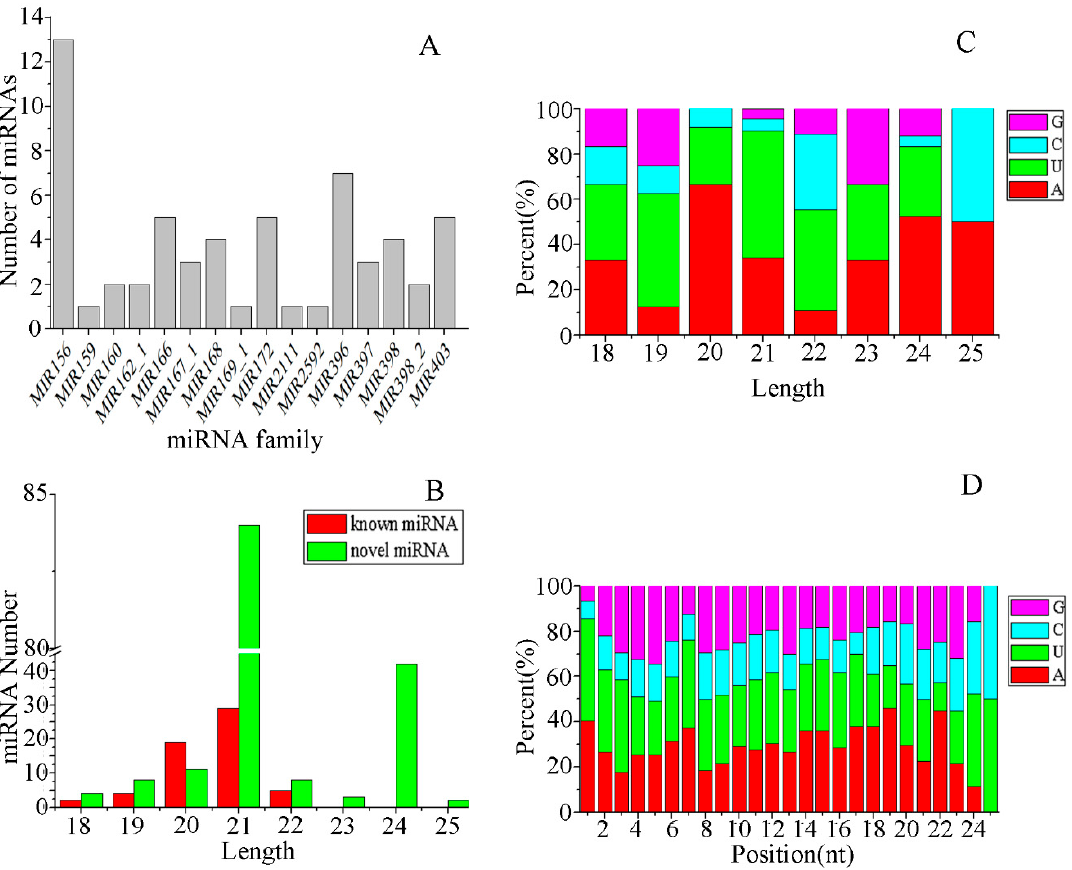
Figure 2. microRNA (miRNA) families, length distribution, and nucleotide bias of miRNAs in E. ulmoides . ( A ) Numbers of identified miRNAs in known miRNA families. ( B ) Length distribution of known miRNAs and novel miRNAs. ( C ) The first nucleotide bias of miRNAs with di ff erent lengths. ( D ) Nucleotide bias at each position in